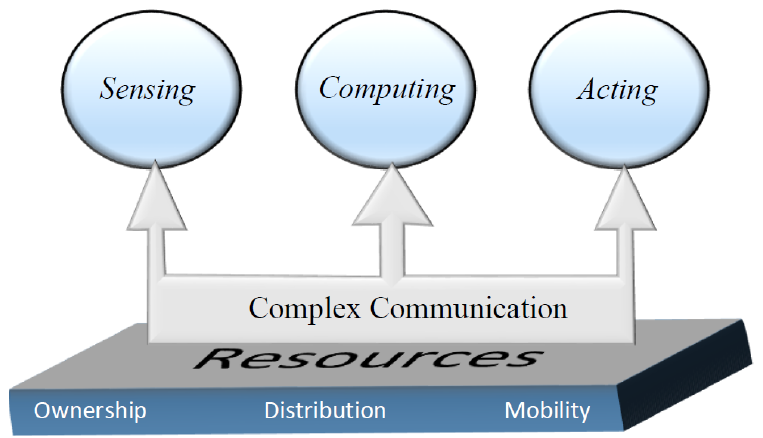
Figure 1. IoT service